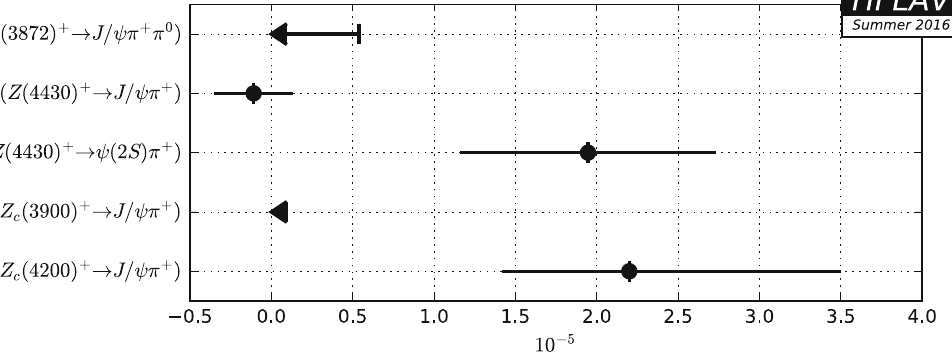
Fig. 104 Summary of the averages from Table